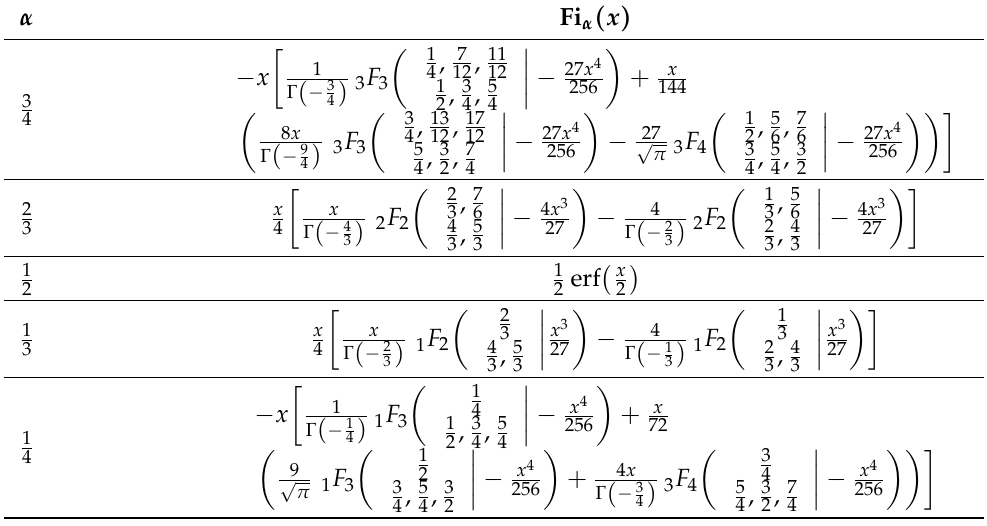
Table 12. The integral Mainardi function Fi α derived for some values of parameter α by using (45). α